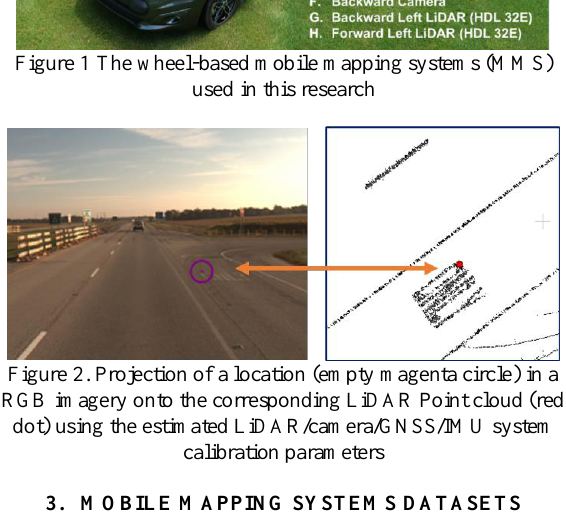
Table 2. Description of the three LiDAR-based MMS point clouds